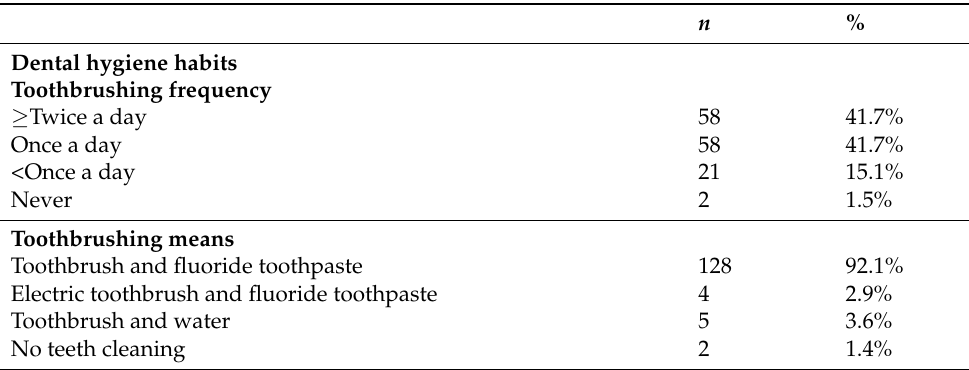
Table 2. Dental hygiene habits and sources of daily dental hygiene information among dentate older individuals ( n =